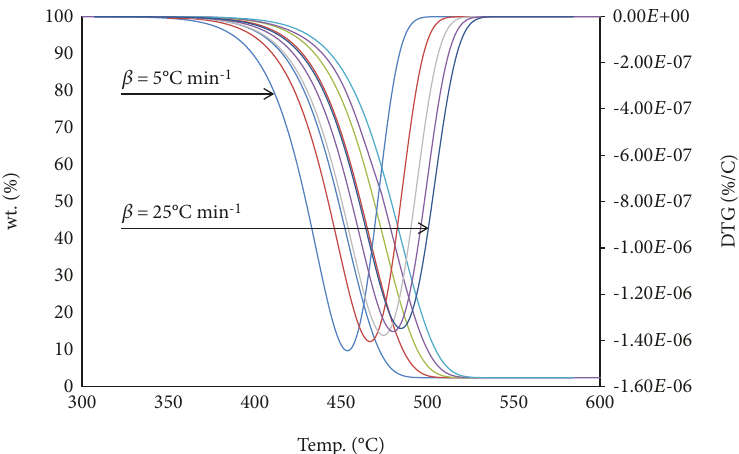
Figure 3: TGA thermogram showing weight loss and fi rst derivative of type II sample pre-exposure with respect to heating rates (5 to 25 ° C min -1 ) in sequential order (left to right).